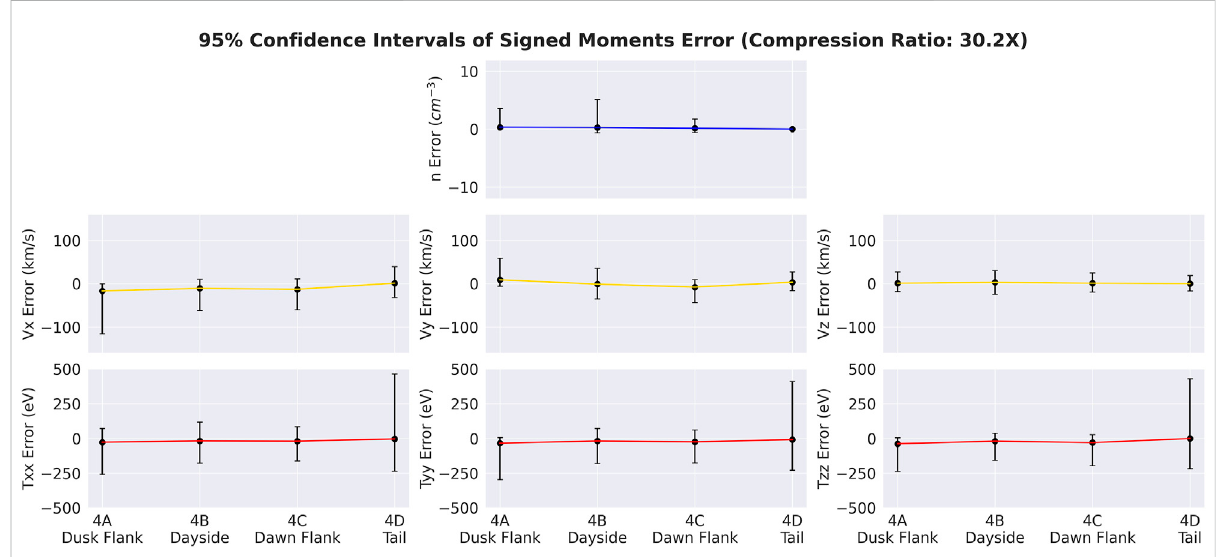
FIGURE 5 AnalysisofSignedErrorsforeachofthemoments(reconstructed — original),investigated through95%con fi denceintervalscalculatedfromthe test set (sample size 5000 ) . The primary line drawn corresponds to the mean signed error, and the error bars correspond to the con fi dence interval. The con fi dence interval can be interpreted to indicate that 95% of the signed errors found in the test set fell between the drawn error bars. The density and temperature moments appear suitable to distinguish dense plasma from sparse plasma and hot plasma from cold plasma, and the velocity components appear suitable to determine the general fl ow direction.